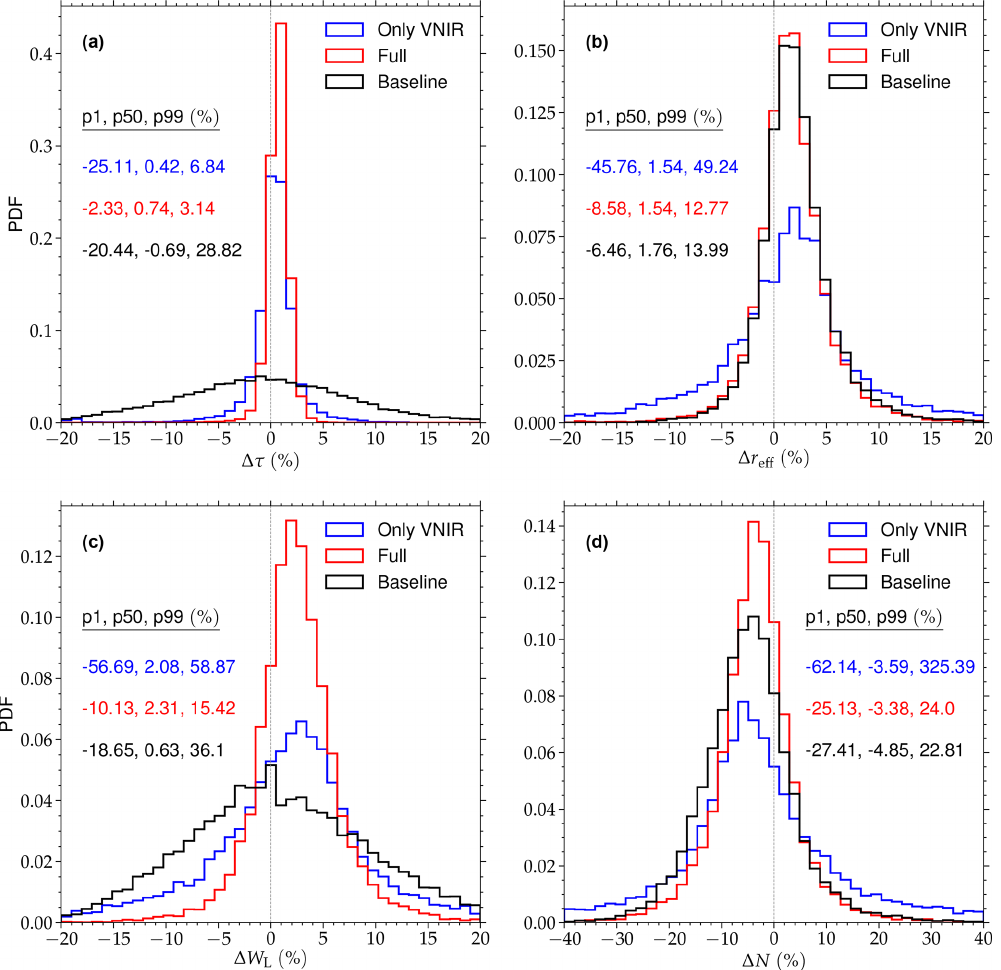
Figure 11. (a) PDFs of the relative differences ( (cid:49)τ ) between the retrieved cloud optical thickness ( τ ) from the baseline test (black), as well as a VNIR-only and full downscaling approach for experiment 3 (shown in blue and red color, respectively), and the reference results (i.e., the original 1km retrievals). Data are from example scene 2 sampled on 9 June 2013 at 10:55UTC, which is shown in Fig. 6b. The 1st, 50th, and 99th percentiles of (cid:49)τ for each experiment are given. (b) Same as (a) but for (cid:49)r eff , which is the relative difference for the retrieved effective droplet radius ( r eff ). (c) Same as (a) but for (cid:49)W L , which is the relative difference for the derived liquid water path ( W L ). (d) Same as (a) but for (cid:49)N D , which is the relative difference for the derived droplet number concentration ( N D